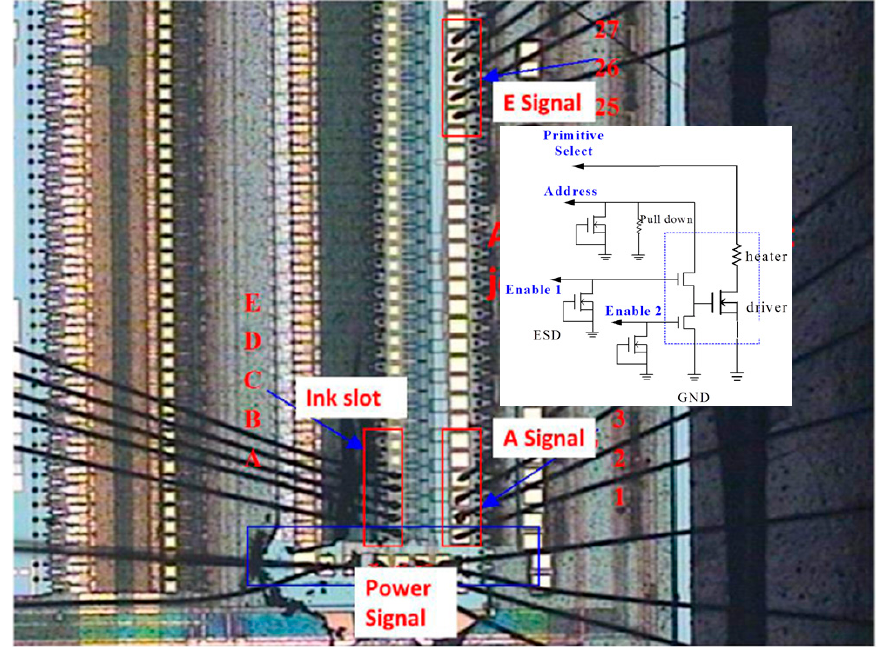
Figure 7. Photo of the chip and schematic diagram of the drive circuit.